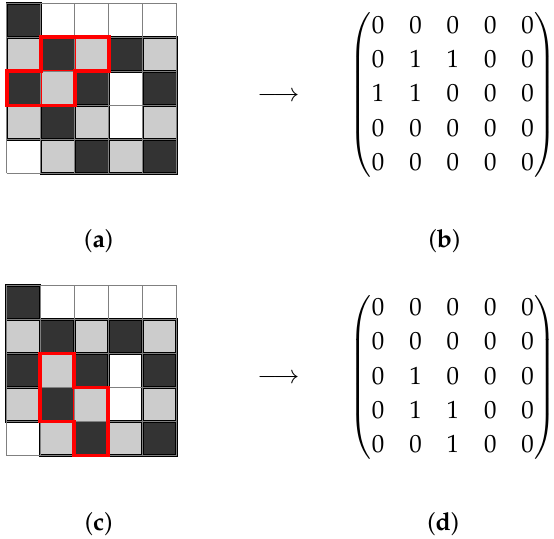
Figure 11. Constructing the binary matrices for two placements of a pariomino in a checkerboard coloured region R : ( a ) first placement of P + ( d ) binary matrix (cid:98) A 1,2 . The pariominoes are outlined in